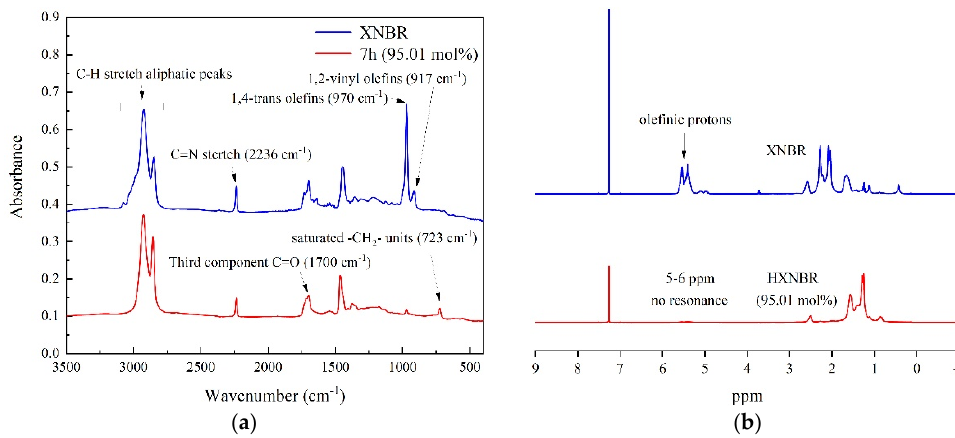
Figure 1. Representative FTIR ( a ) and 1 H NMR ( b ) spectra of both XNBR and HXNBR (95.01 mol%) with an XNBR conversion rate of 95.01 mol% (reaction conditions: catalyst = 0.035 wt%, latex solid content = 11.25 wt%, reaction temperature = 120 °C, stirring speed = 450 rpm, hydrogen pressure = 1200 psi) .